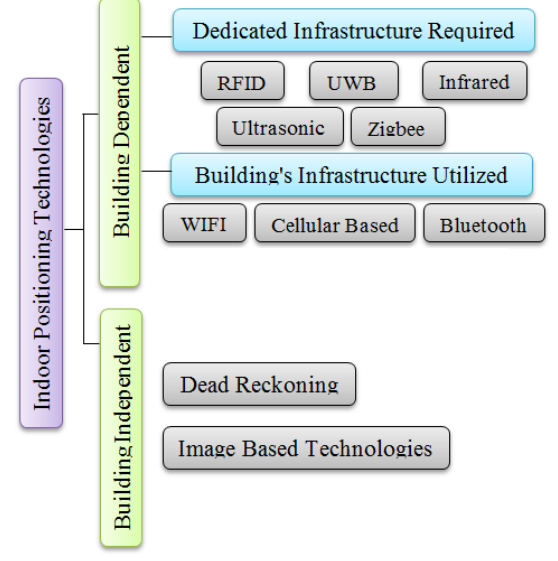
Figure 3. Classification of indoor positioning